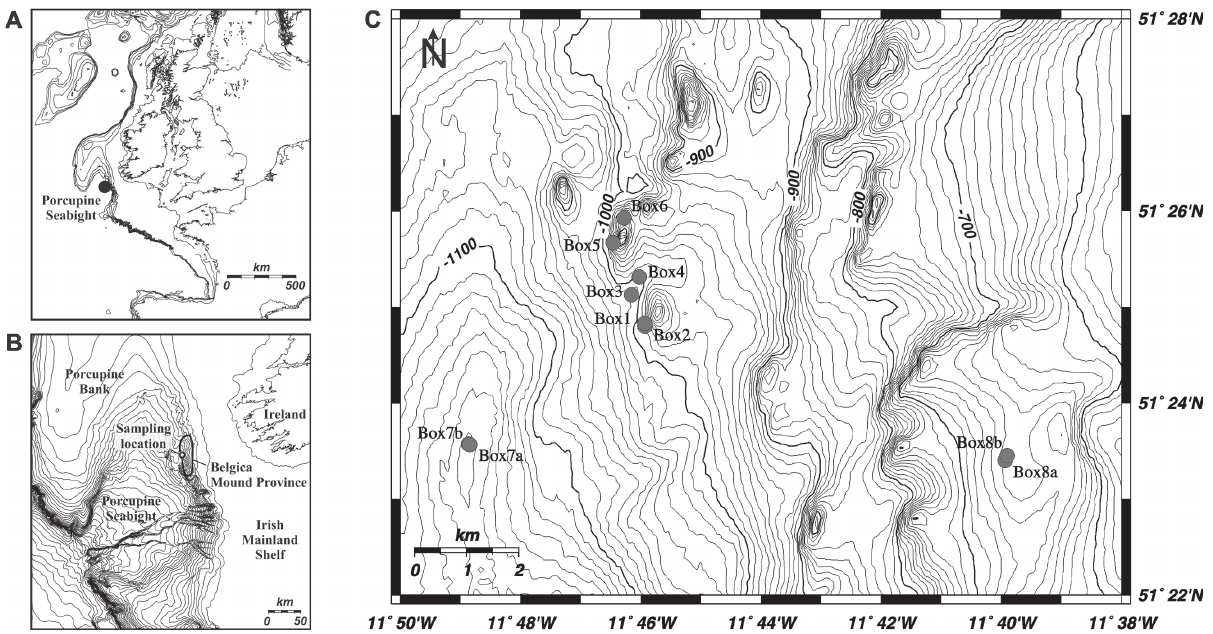
Fig . 1. – (a) location of the Porcupine seabight (ne atlantic ocean) along the european continental margin, (B) sampling location in the Belgica Mound Province, and (c) a detail showing the ridge of mounds in the Belgica Mound Province, with boxcorers 1-6 taken in the coral degradation zone of two seabed mounds, and boxcorers 7a-b and 8a-b from coral-free sediments (multibeam bathymetry by courtesy of aWi Bremerhaven, contour interval at 10 m). Table 1. – depth, date, geographical position, and microhabitats sampled per boxcorer taken at the Porcupine seabight. (sed = underlying sediment, cor = coral fragment, spo = sponge skeleton)